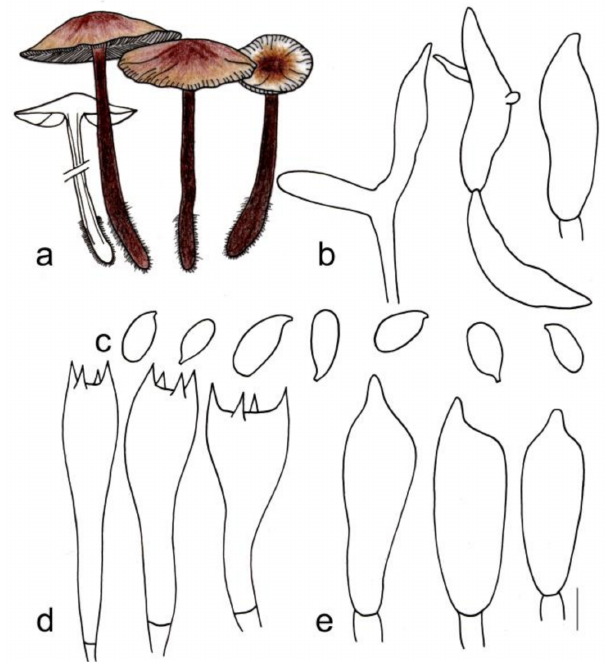
Figure 7. Morphological characteristics of Gymnopus striatus (HMJAU 60297, holotype): ( a ) basid- iomata, ( b ) pileipellis, ( c ) basidiospores, ( d ) basidia, and ( e ) cheilocystidia. Scale bars: 1 cm ( a ), 25 µ m ( b ), and 5 µ m ( c – e